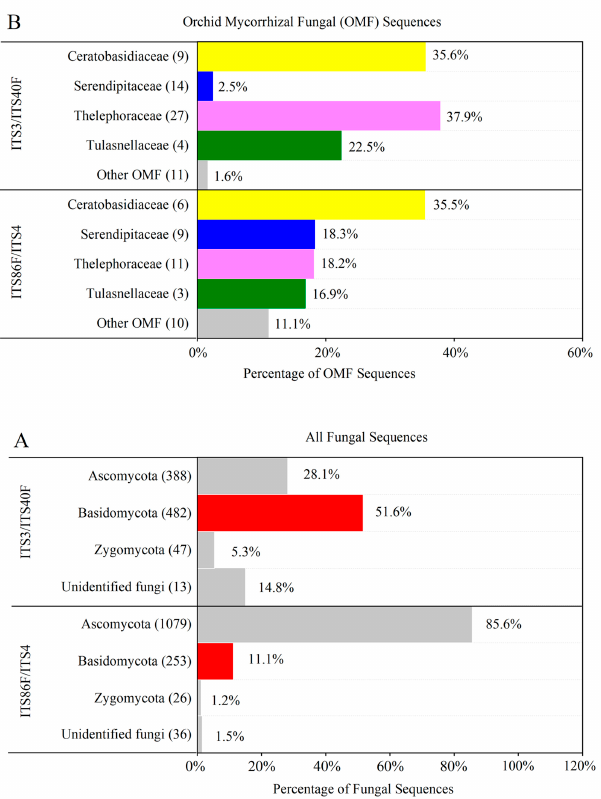
Figure 1. Frequency distribution of sequences generated from the four Habenaria root samples using primer combinations ITS3/ITS4OF and ITS86F/ITS4, including ( A ) all sequences identified by BLAST as representing fungal phyla, and ( B ) only those matching orchid mycorrhizal fungi (OMF) families previously described in the studied orchid species (refer to Table S2). Fungal phyla containing the most abundant OMF families are highlighted in red and the number of OTUs corresponding to each taxa are indicated within